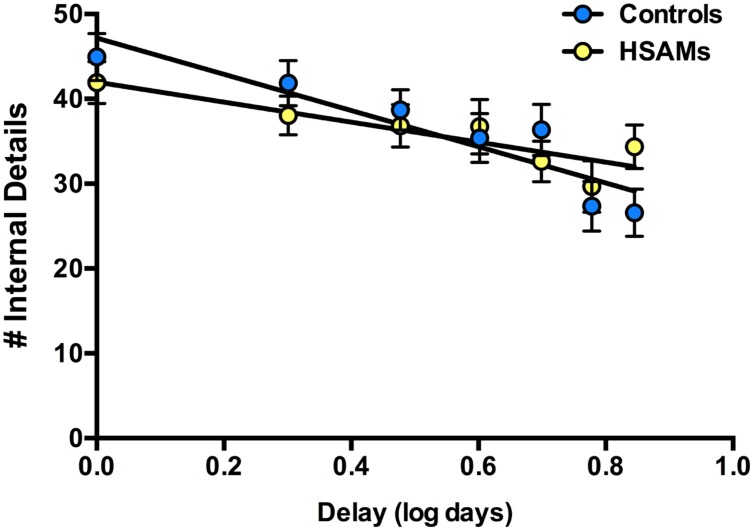
Total internal autobiographical details recalled over past 7 days. HSAM participants (n = 28, yellow circles); Controls (n = 29, blue circles). Slopes do not differ significantly from one another (p = 0.071). All values are means ± SEM.